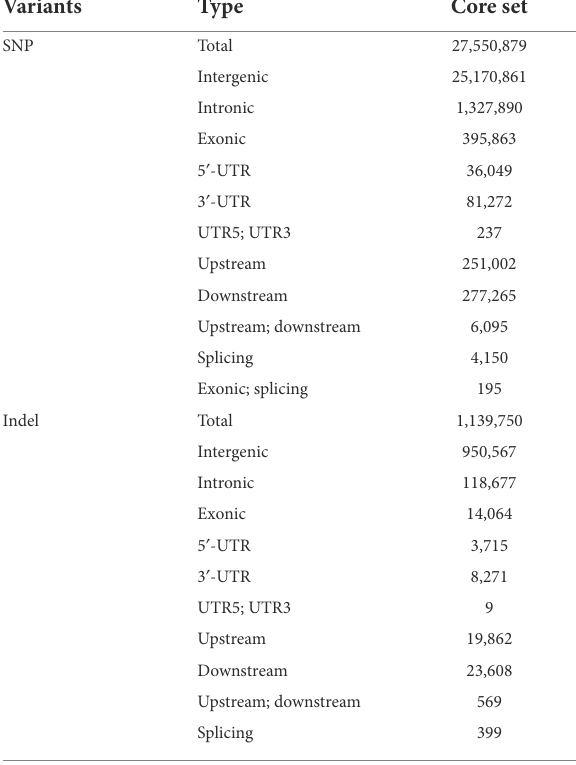
TABLE 3 The number of large-effect SNPs and